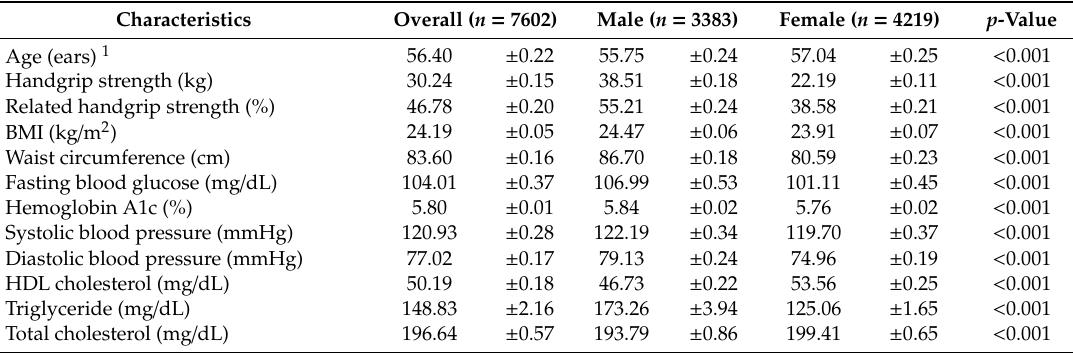
Table 1. Participants’ characteristics overall, in males and in